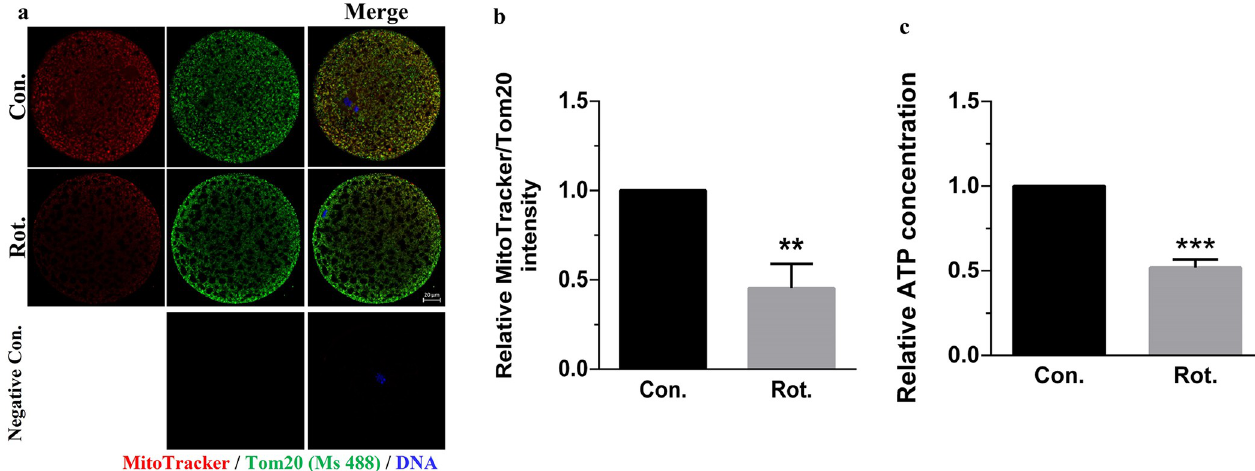
Fig 3. Rotenone induces mitochondrial dysfunction in porcine oocytes. (A) Relative fluorescence intensity of Mito-Tracker and TOM20 in porcine oocytes after rotenone treatment. Red = Mito-Tracker, green = TOM20, blue = DNA. Scale bars represent 20 μ m. (B) Ratio of Mito-Tracker/TOM20, representing the number of functional mitochondria and total mitochondria, respectively (n = 30). (C) Relative ATP production in control and rotenone-treated oocytes (n = 16). Con., control group. Rot., 3 μ M rotenone-exposed group. Negative Con., only the secondary antibody was stained in mature oocytes as a negative control. �� (P < 0.01), ��� (P <